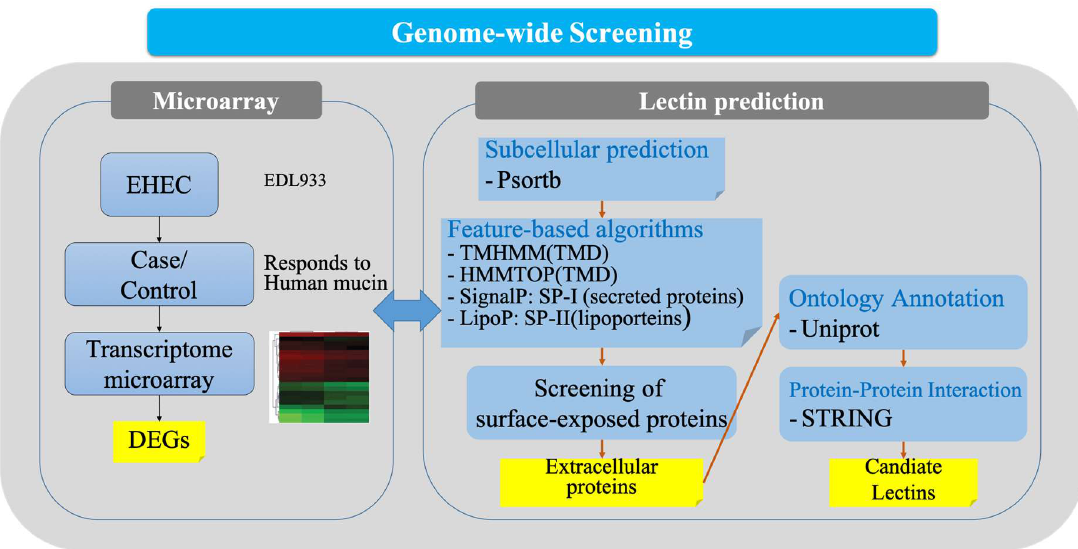
Figure 5. A two-step approach for lectin candidate